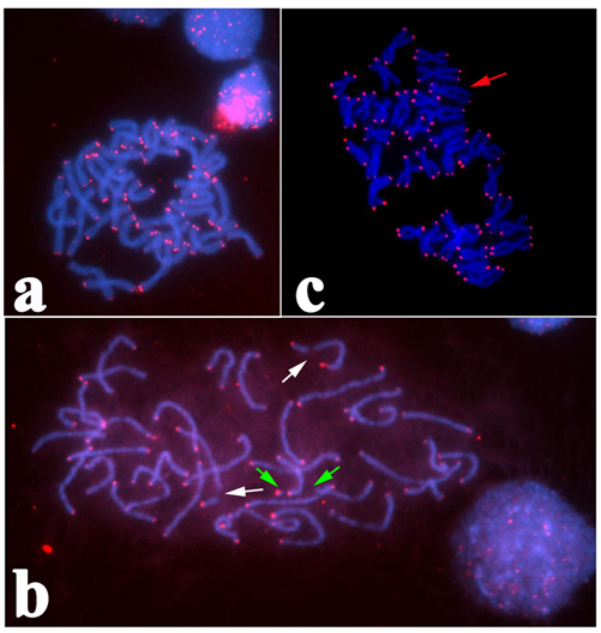
Fig 3. 18S rDNA location on chromosome of H. discus hannai . a: Mitotic metaphase chromosomes after FISH treatment with the telomeric sequence (CCCTAA) n . b: Three breaks on prophase chromosome of H. discus hannai , white arrows indicate two breaks in the centromere region and the green arrow indicates the terminal break. c: A rare karyotype with st chromosome, red arrow indicated st chromosome. (cy 3 shown as red color and DAPI shown as blue color.)